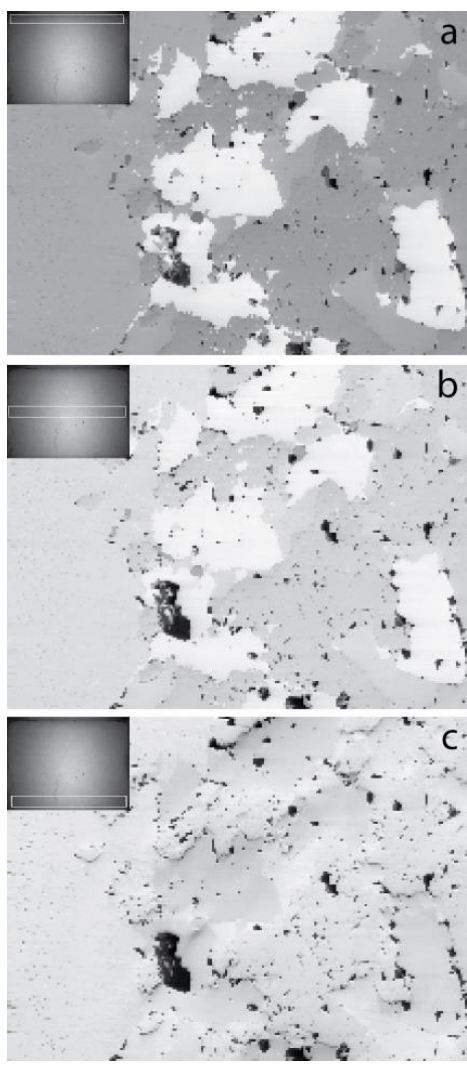
Figure 6. Reconstructed images from the same EBSD scan as in Figure 5. The white rectangles in the reference image shown in the inset define the pixel arrays integrated to obtain each image. ( a ) Top; ( b ) center and ( c ) bottom region of the EBSD camera. The scalebar displayed on the image in Figure 5a applies to all the reconstructed images of this figure.